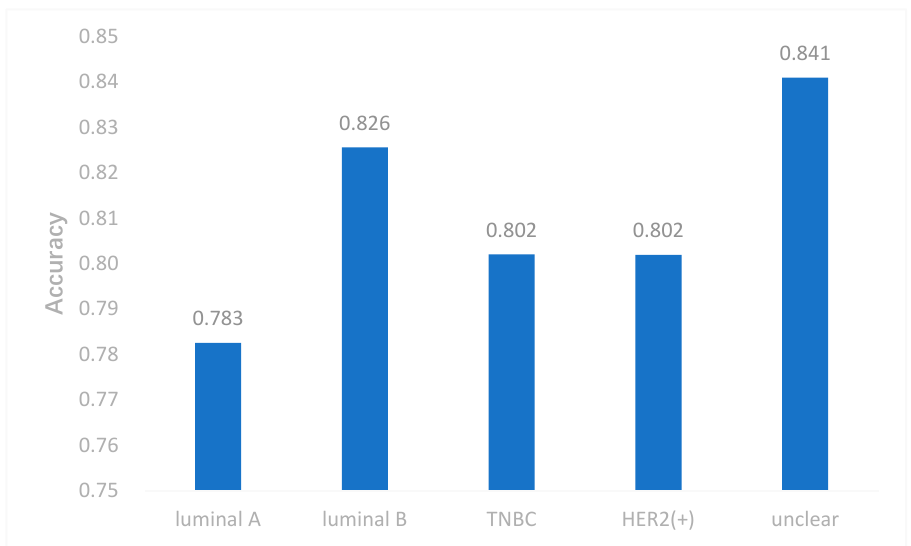
Figure 4. The accuracy by using single omics data and multi-omics data.